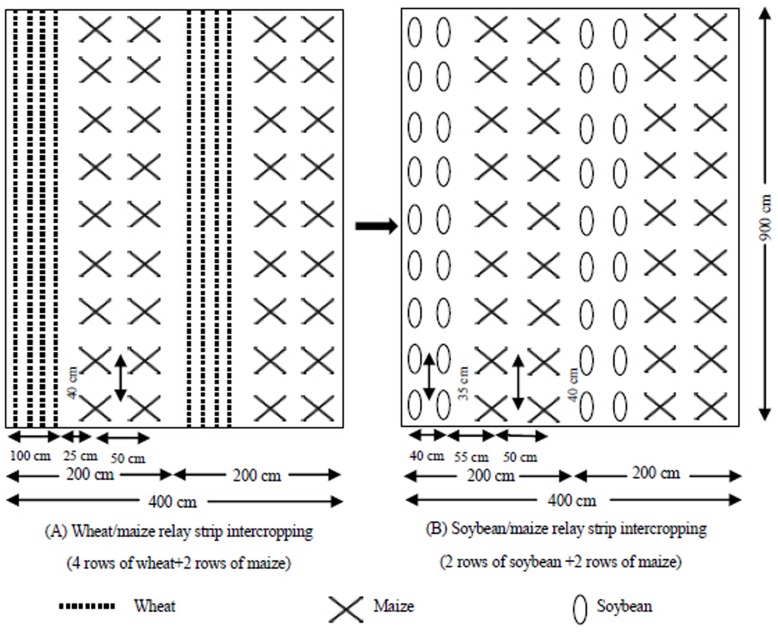
Diagram showing the arrangement of wheat intercropped with maize (A) and maize intercropped with soybean (B) in the field plot.